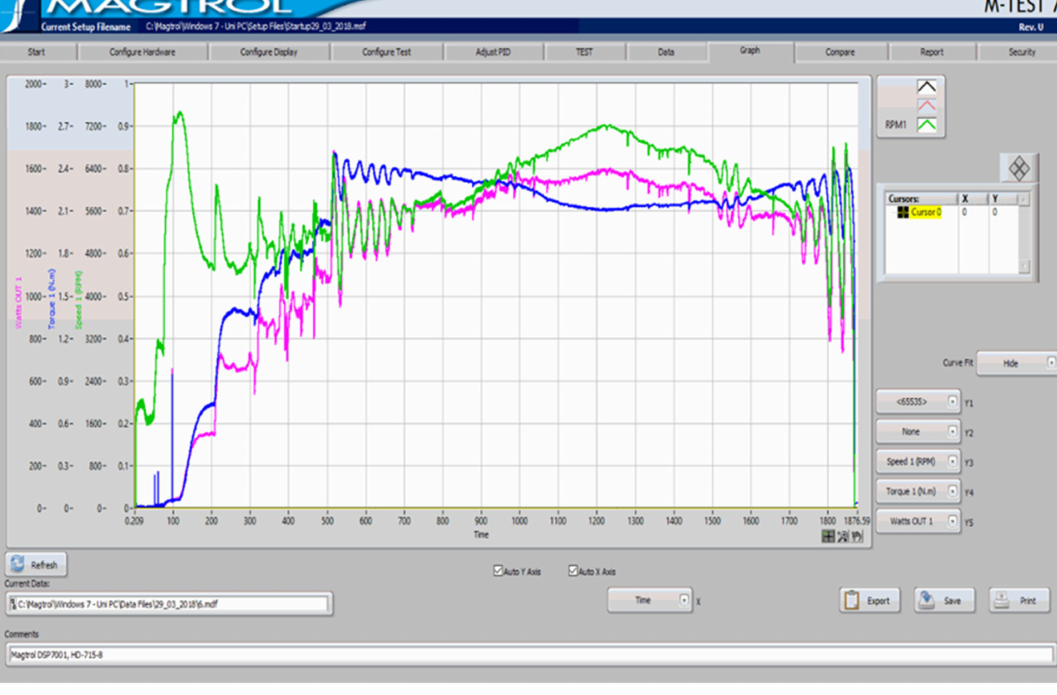
Figure 2. Evolution of the Saito FG-40 engine during an experimental dynamometer